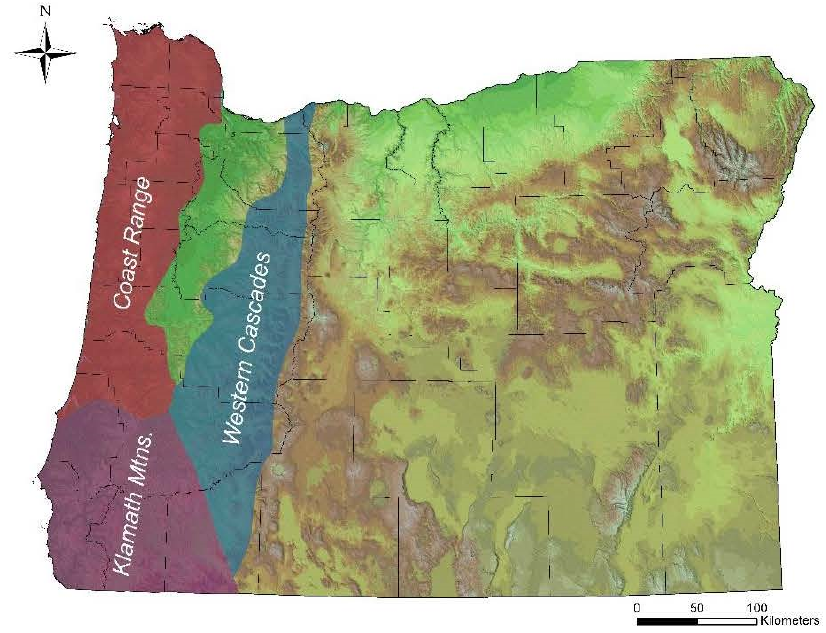
Figure 1. Mountain ranges of western Oregon, USA.